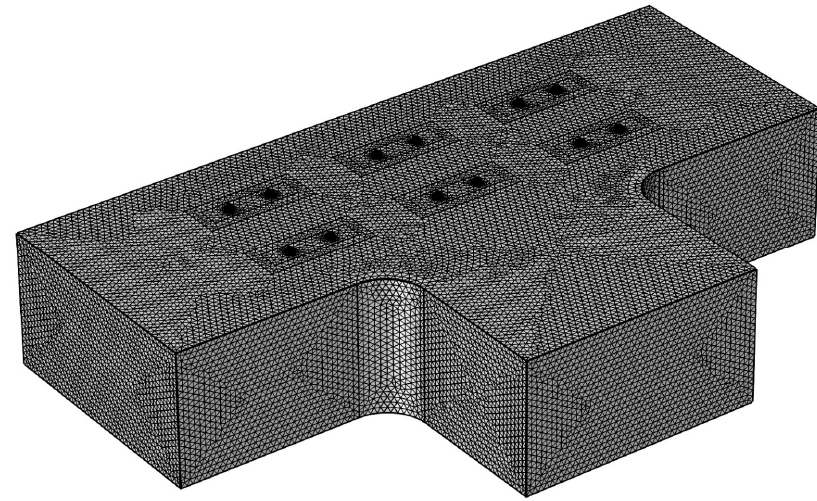
Figure 2. A schematic of the grid used for the present simulations. Batteries 2023 , 9 , x FOR PEER REVIEW